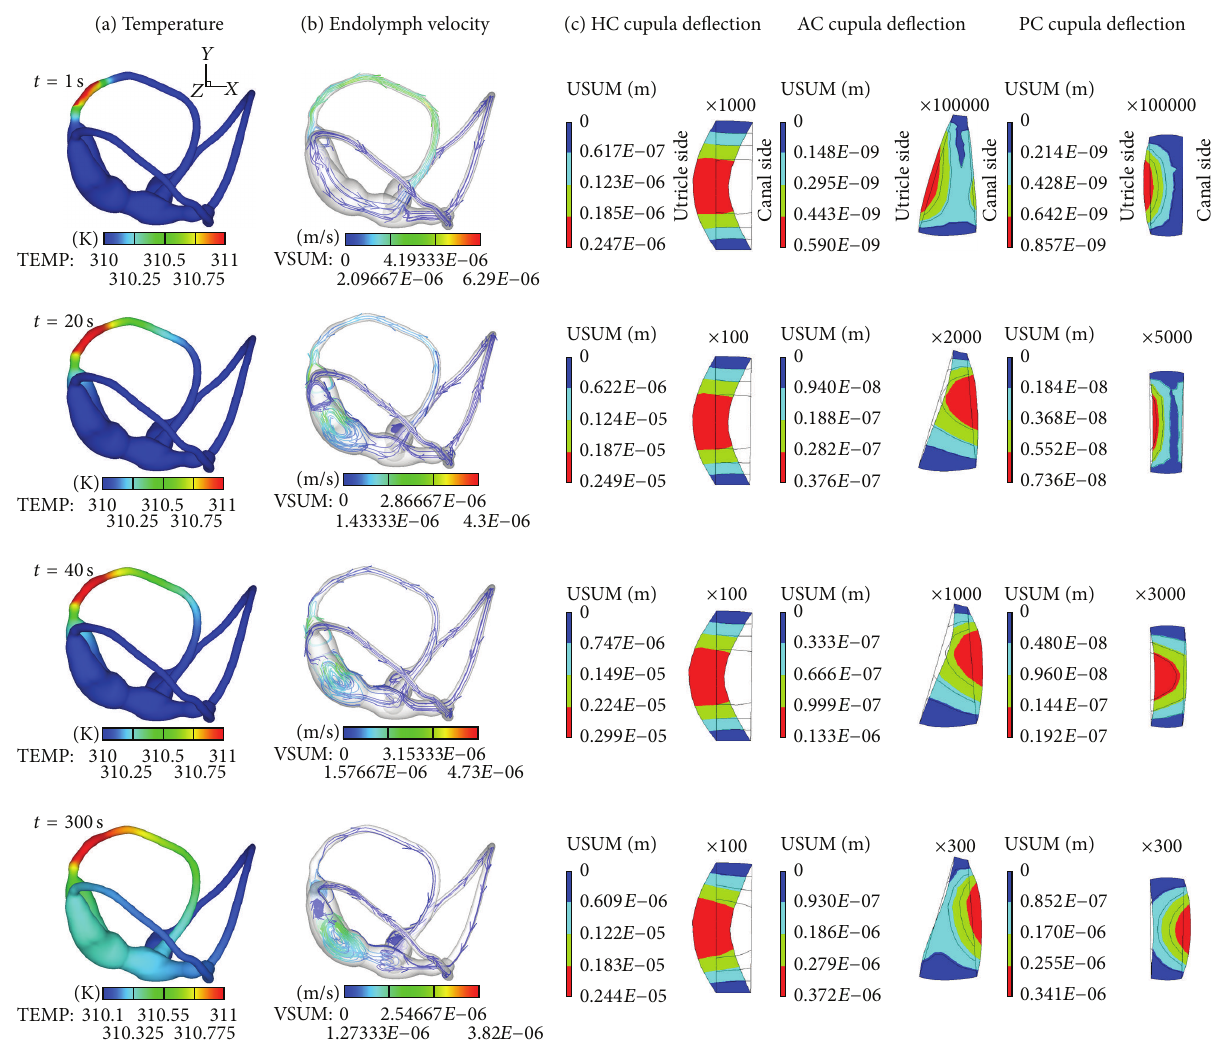
Figure 2: Time sequences of the temperature field (a), the endolymph streamline (b), and cupula displacement fields (c) during a hot supine caloric test with Δ𝑇 = 1 ∘